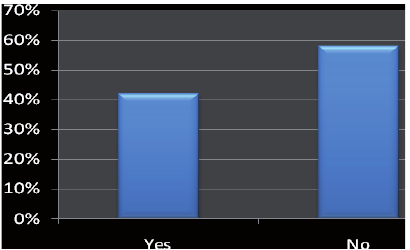
Fig. 2.1. Knowledge about psychomotor Fig. 2.2. knowledge about the education and its standards. programme and speci fi c objections.